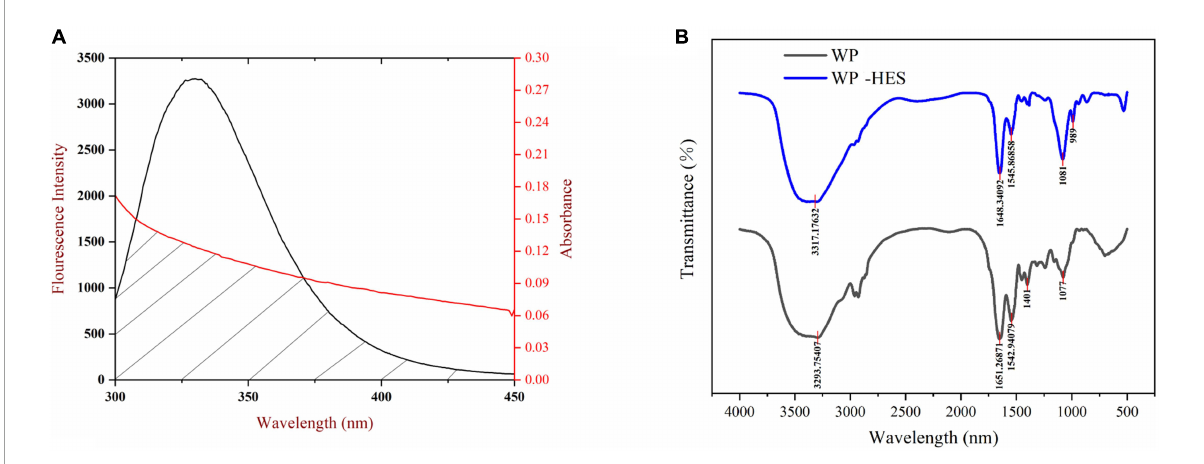
FIGURE2 The overlapping area of the UV-VIS absorption spectrum of HES and the WP fluorescence spectrum (A) , the red line and black line represent UV-VIS absorption spectrum and fluorescence spectrum, respectively; FTIR spectrograms of WP and WP-HES (B) .